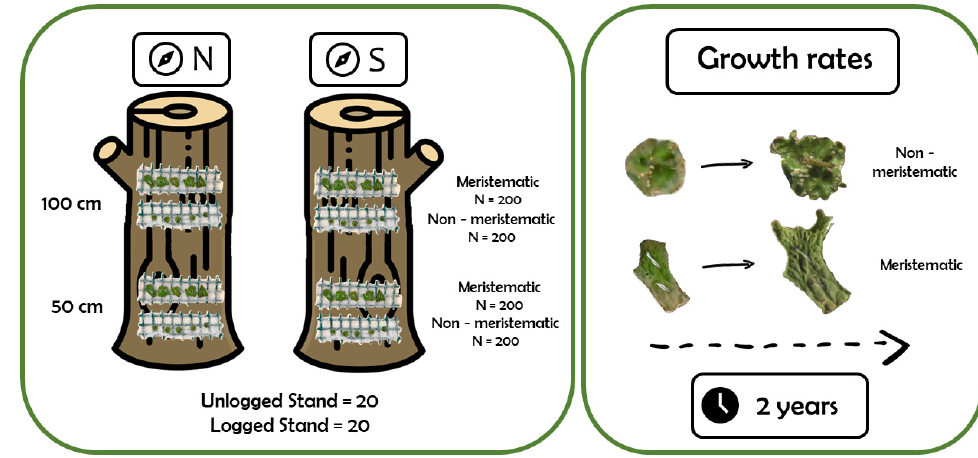
Figure 4. Graphical representation of the experimental design. Icons: Flaticon.com.